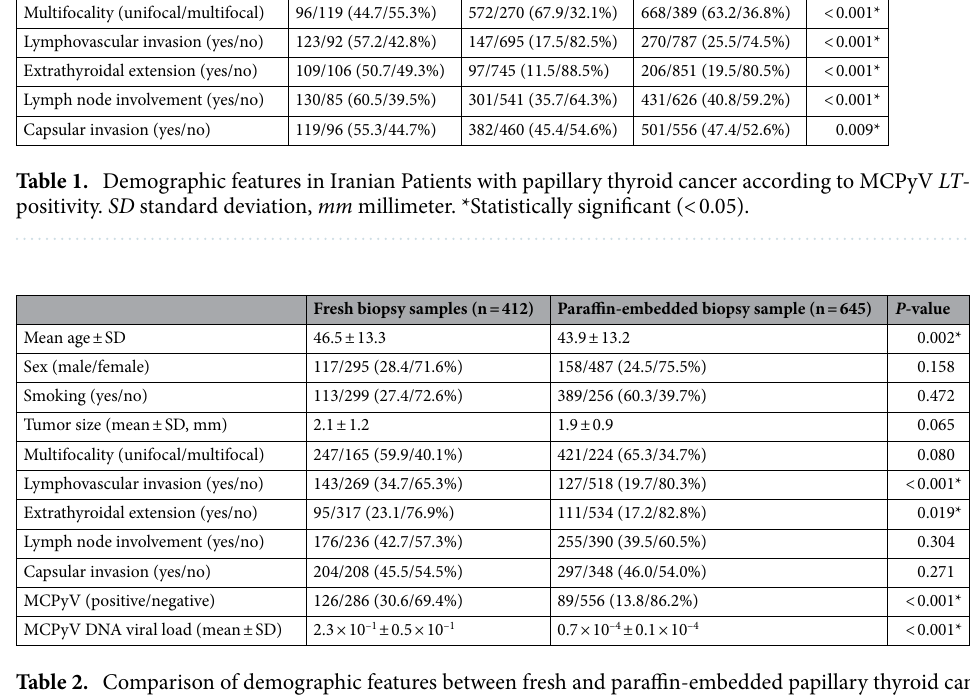
Table 2. Comparison of demographic features between fresh and paraffin-embedded papillary thyroid cancer biopsy samples. SD standard deviation, mm millimeter . *Statistically significant (<